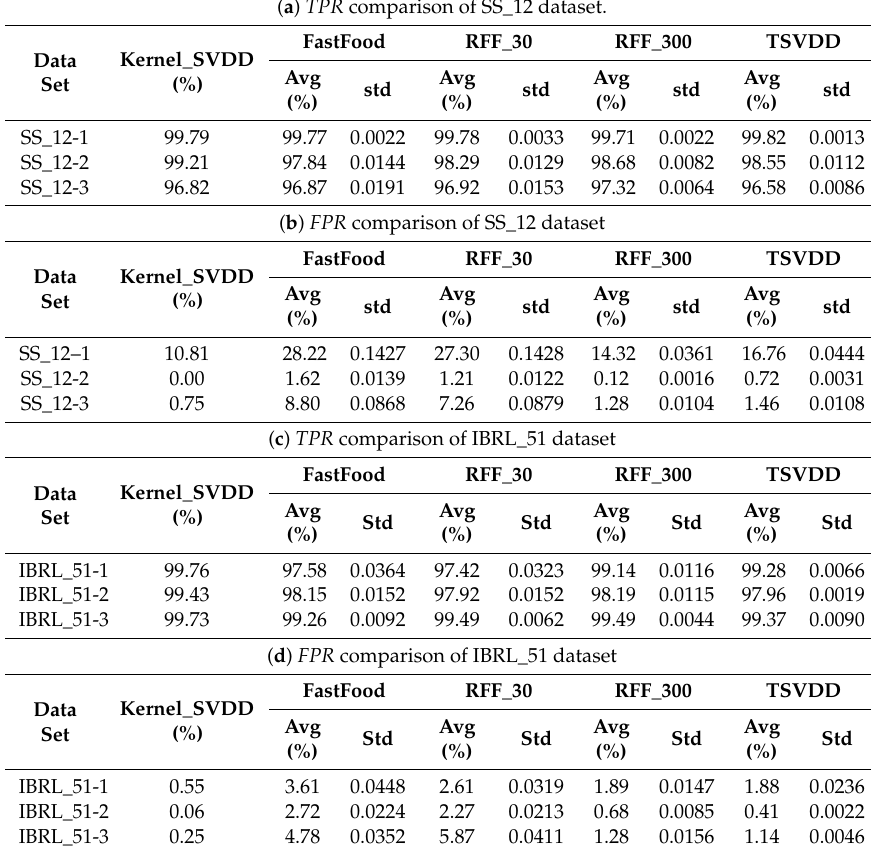
Table 3. Performance comparison of various algorithms under different data